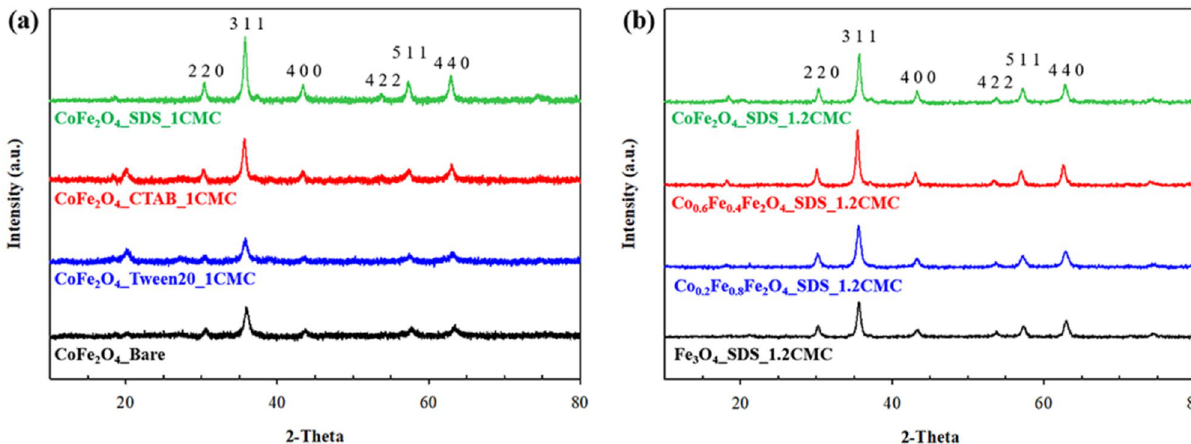
Figure 2. XRD patterns of CoFe 2 O 4 and Co x Fe 1−x Fe 2 O 4 : ( a ) under various surfactant types; ( b ) under various Fe 2+